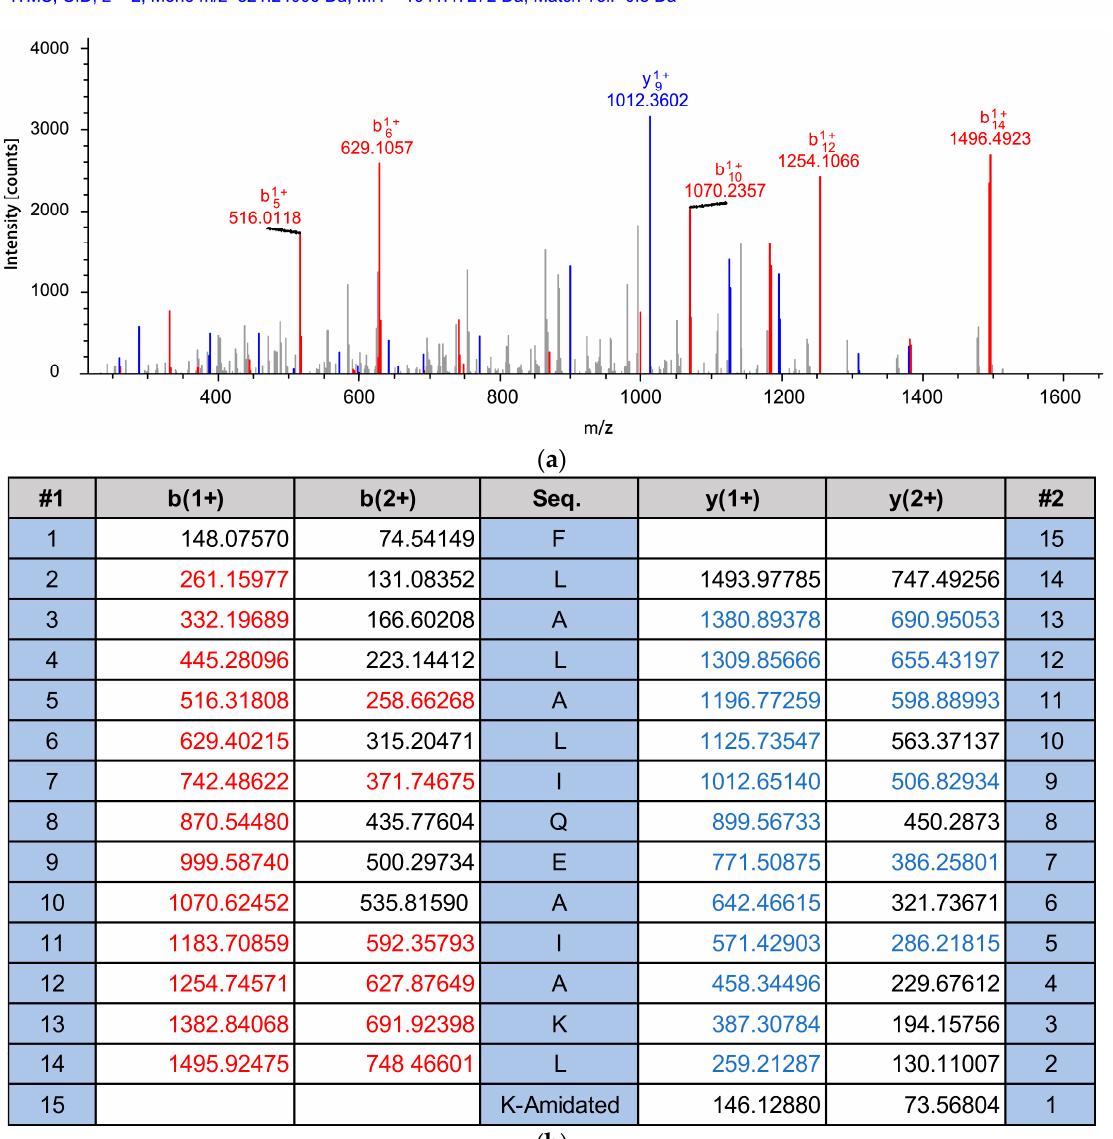
Figure 3. The MS/MS fragment mass spectrum of doubly charged ions of kassporin-KS1 (QUB-1641) ( a ) and the MS/MS ion dataset predicted from the biosynthetic precursor ( b ). The predicted b-ions and y-ions are respectively marked in red and blue. The “Seq.” column in the table was the amino acid sequence of the novel peptide.